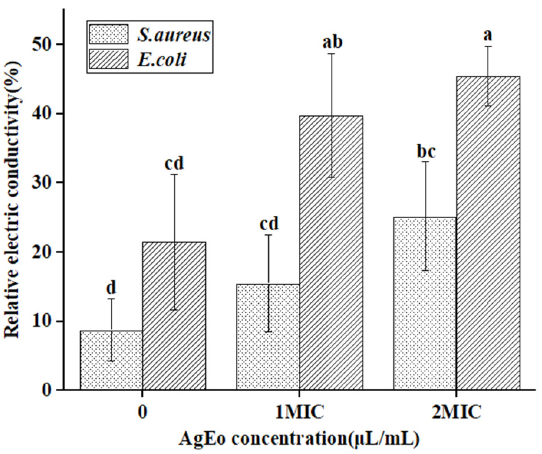
Figure 8. Effect of AgEo against cell membrane permeability of E. coli and S. aureus. Different normal letters indicate significant differences between treatments ( p < 0.05, n = 3). letters indicate significant differences between treatments ( p < 0.05, n =